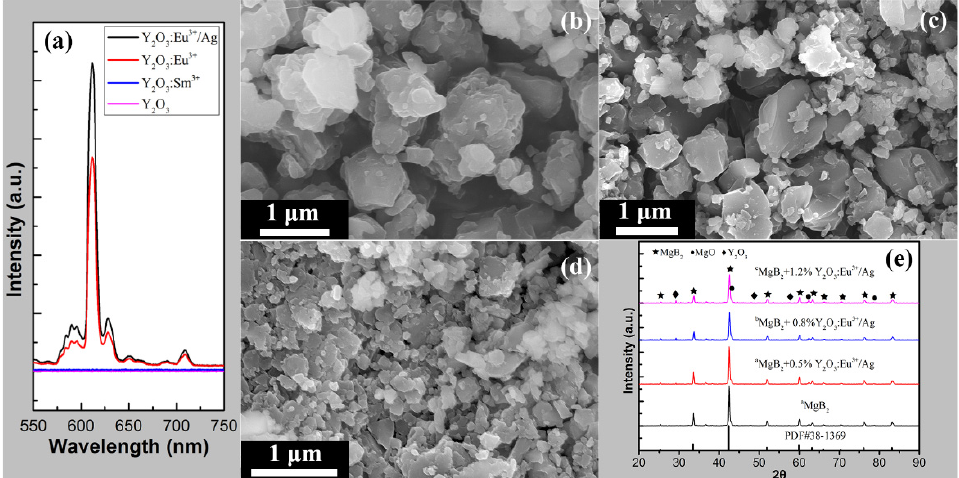
Figure 2. ( a ) EL intensities of Y 2 O 3 , Y 2 O 3 :Sm 3+ , Y 2 O 3 :Eu 3+ , and Y 2 O 3 :Eu 3+ /Ag. ( b – d ) SEM images of a MgB 2 , b MgB 2 , and c MgB 2 . ( e ) XRD patterns of a MgB 2 , a MgB 2 + 0.5% Y 2 O 3 :Eu 3+ /Ag, b MgB 2 + 0.8% Y 2 O 3 :Eu 3+ /Ag, and c MgB 2 + 1.2% Y 2 O 3 :Eu 3+ /Ag.